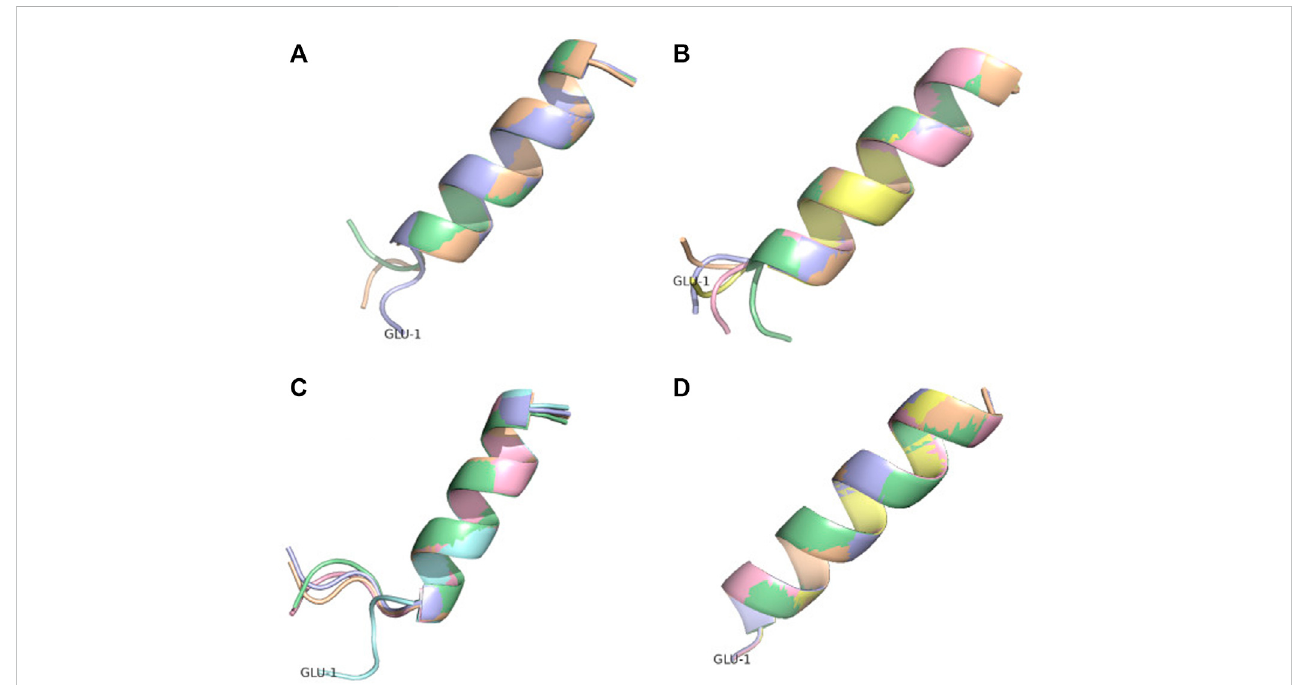
FIGURE 7 Conformational ensemble of pep17. (A) PF-noDH, (B) PF-DH — pH 2, (C) AlphaFold2 and (D) TrRosetta. For each method, the 5 predicted models are depicted.